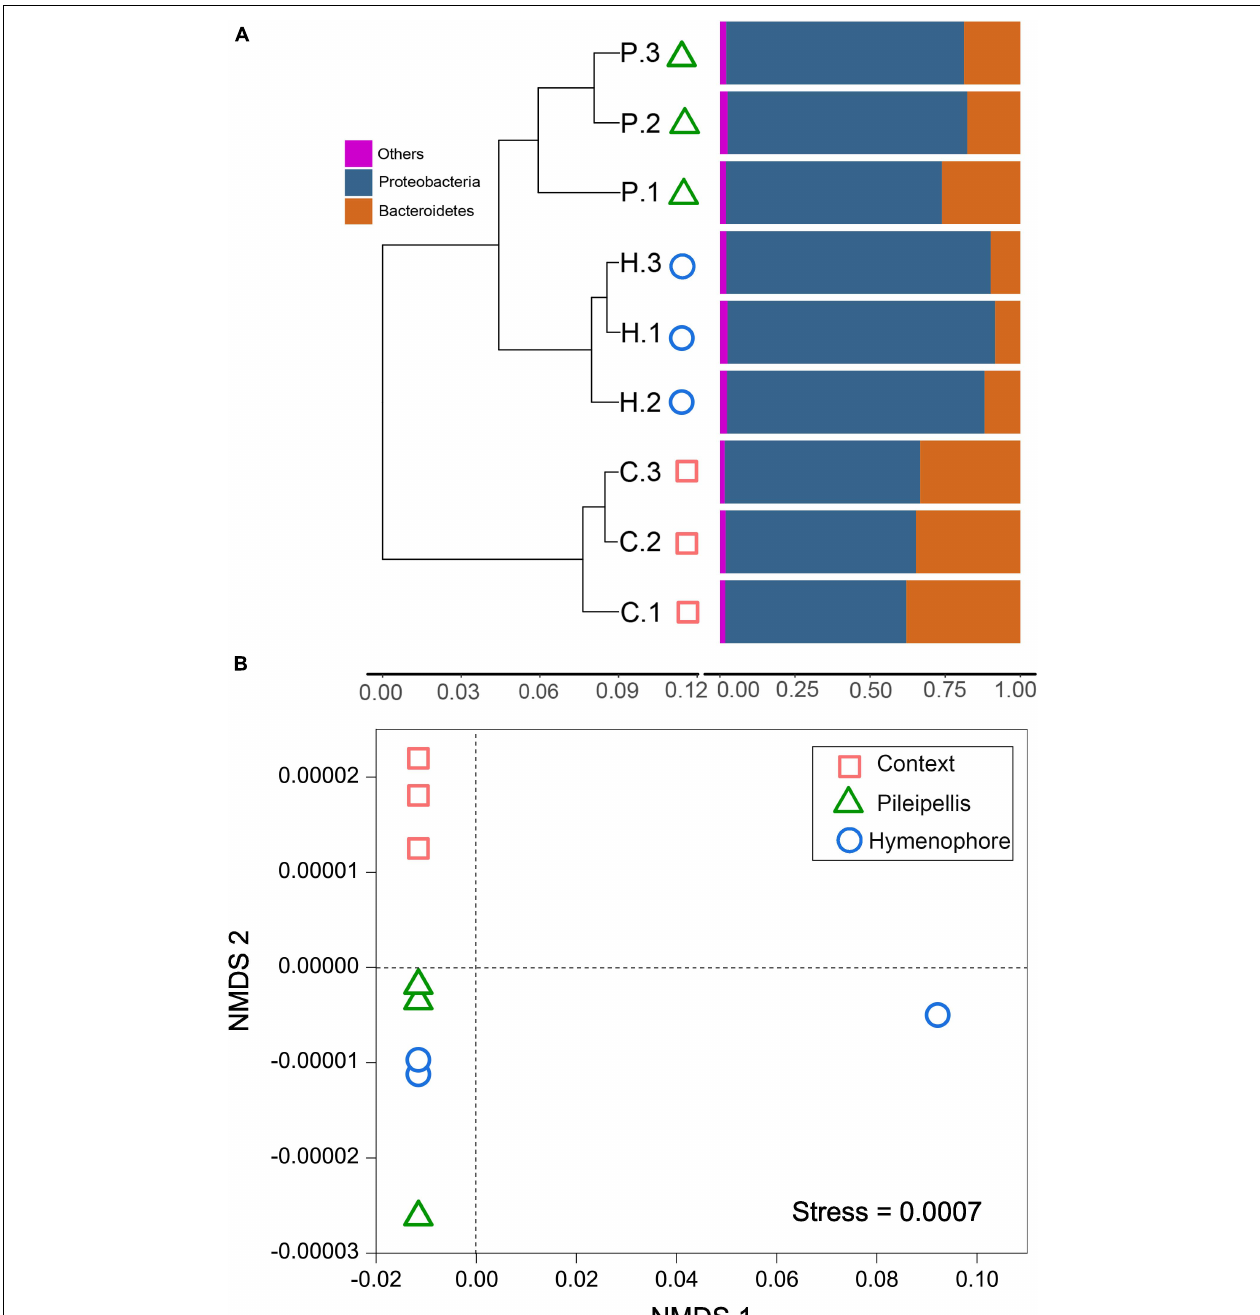
FIGURE 3 | The beta diversity changes in Thelephora ganbajun bacterial communities. (A) Two-way cluster based on an unweighted UniFrac UPGMA tree; and (B) functional genes analyzed via unweighted non-metric multidimensional scaling (NMDS) plots in three sporocarp compartments. In (A) abbreviations are C, context; H, hymenophore; P, pileipellis and the numbers 1, 2, 3 denote the replicates for each